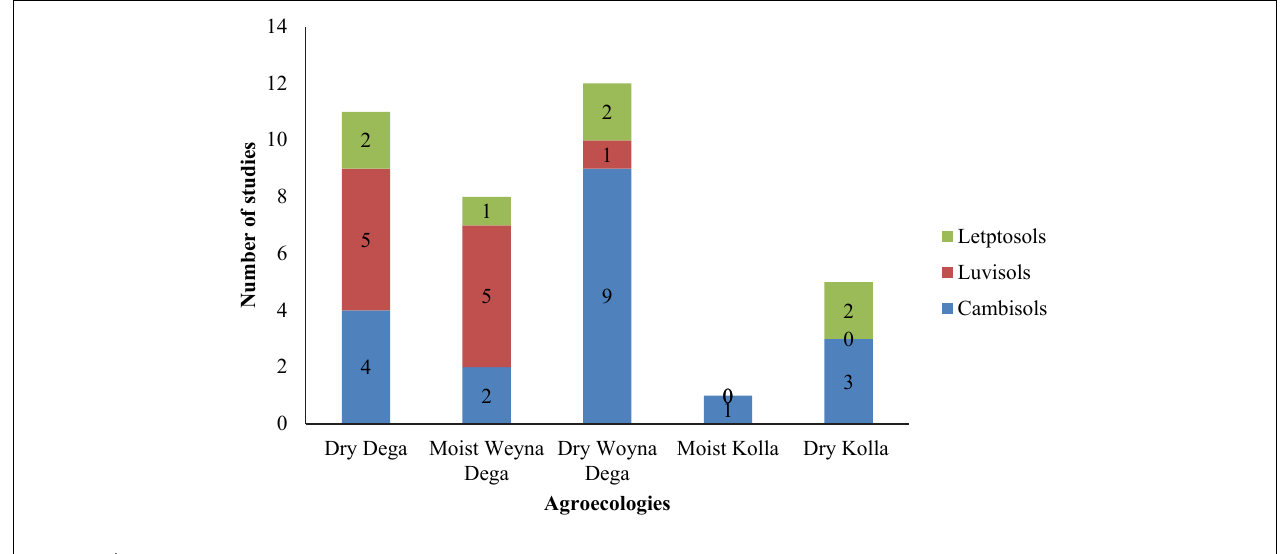
FIGURE 4 | Distribution of the three soil types across the agroecological zones.